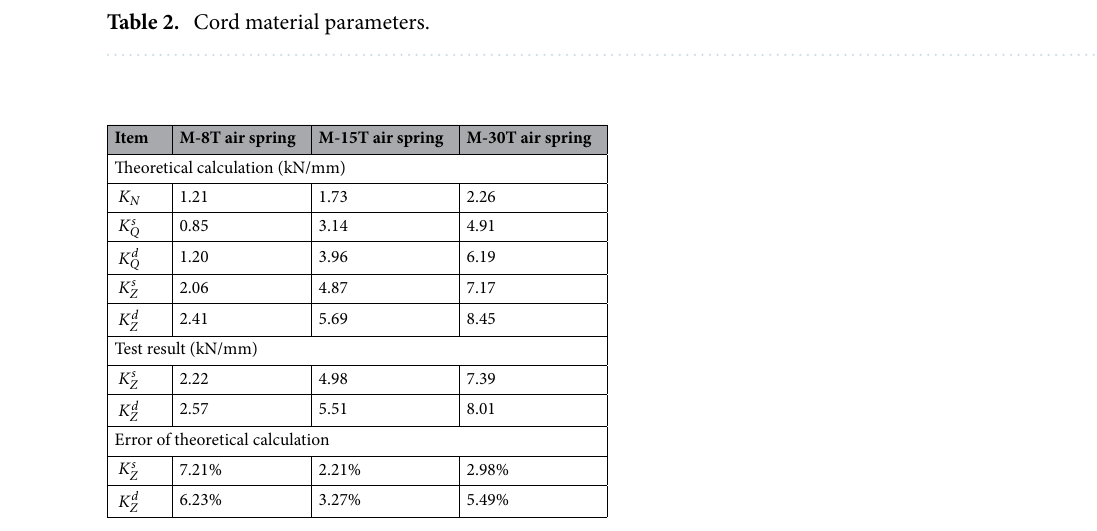
Table 3. Theoretical calculation and test